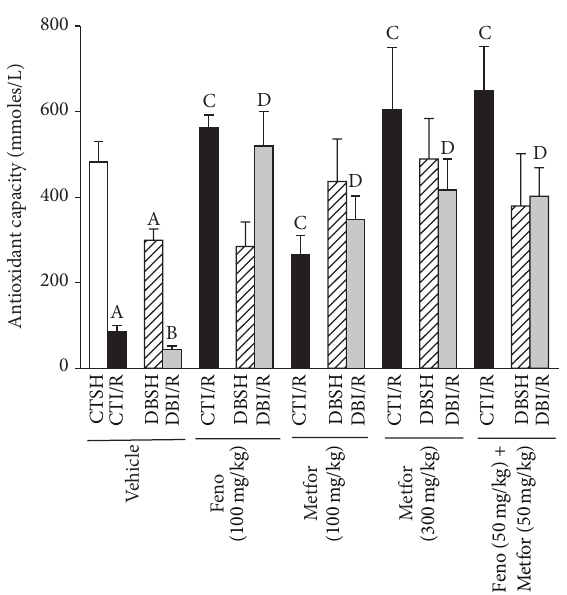
Figure 6: Effect of fenofibrate, metformin, and fenofibrate + metformin on serum antioxidant capacity. Total antioxidant capacity was evaluated in serum from control- (CT-) and diabetic- (DB-) rats subjected to sham- (SH-) or ischemia/reperfusion- (I/R-) myocardial infarction and treated subchronically (14d) with either vehicle, fenofibrate (Feno, 100mg/kg), metformin (Metfor, 100 or 300 mg/kg), or Feno (50 mg/kg) + Metfor (50mg/kg). Data are presented as means ± SEM ( 𝑛 = 6 –14 rats/group). A 𝑃 < 0.05 versus CTSH-Vehicle, B 𝑃 < 0.05 versus DBSH-Vehicle, C 𝑃 < 0.05 versus CTI/R-Vehicle, and D 𝑃 < 0.05 versus DBI/R-Vehicle two-way ANOVA followed by Duncan’s post hoc test.